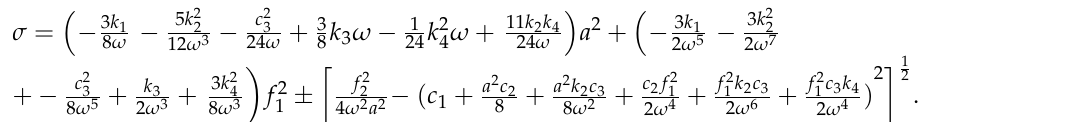
Figure 5. The phase portraits of primary resonant excitation for